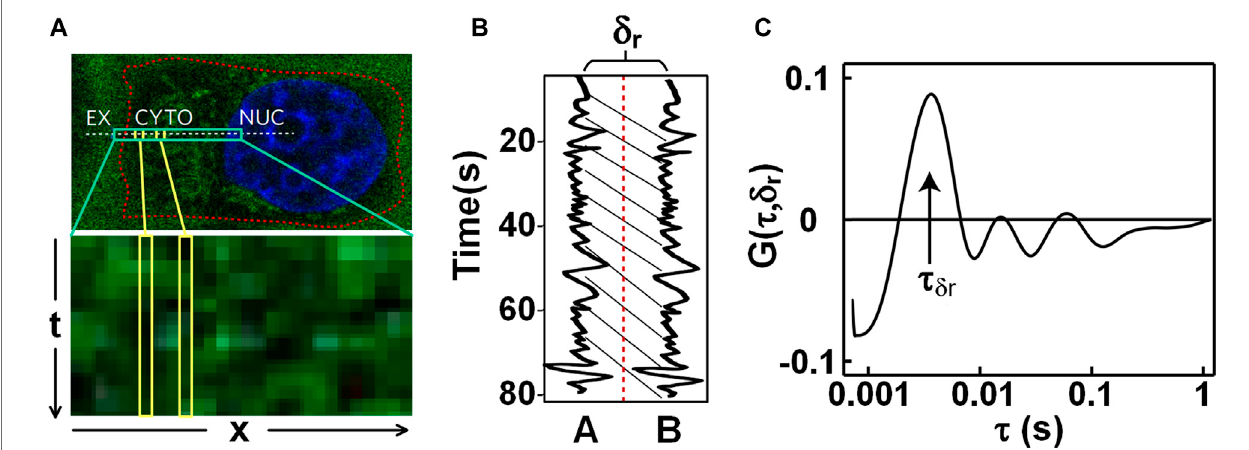
FIGURE4| Paircorrelationfunction(pCF)analysisonnanoparticlestransmittinginlivecells.( A )FluorescenceimageofnanoparticlesandHoechst-stainednucleus ( Top ) and the kymograph ( Bottom ). The dash-line indicates the scanned line across the extracellular space (EX), the cytoplasm (CYTO), and the nucleus (NUC). ( B ) Fluorescenceintensity fl uctuationsoftwopixelswithadistanceof δ r inthesample.( C )Paircorrelationcurve G ( τ , δ r )calculatedwiththetwointensitytracesin Figure4B . Adapted from Ref.